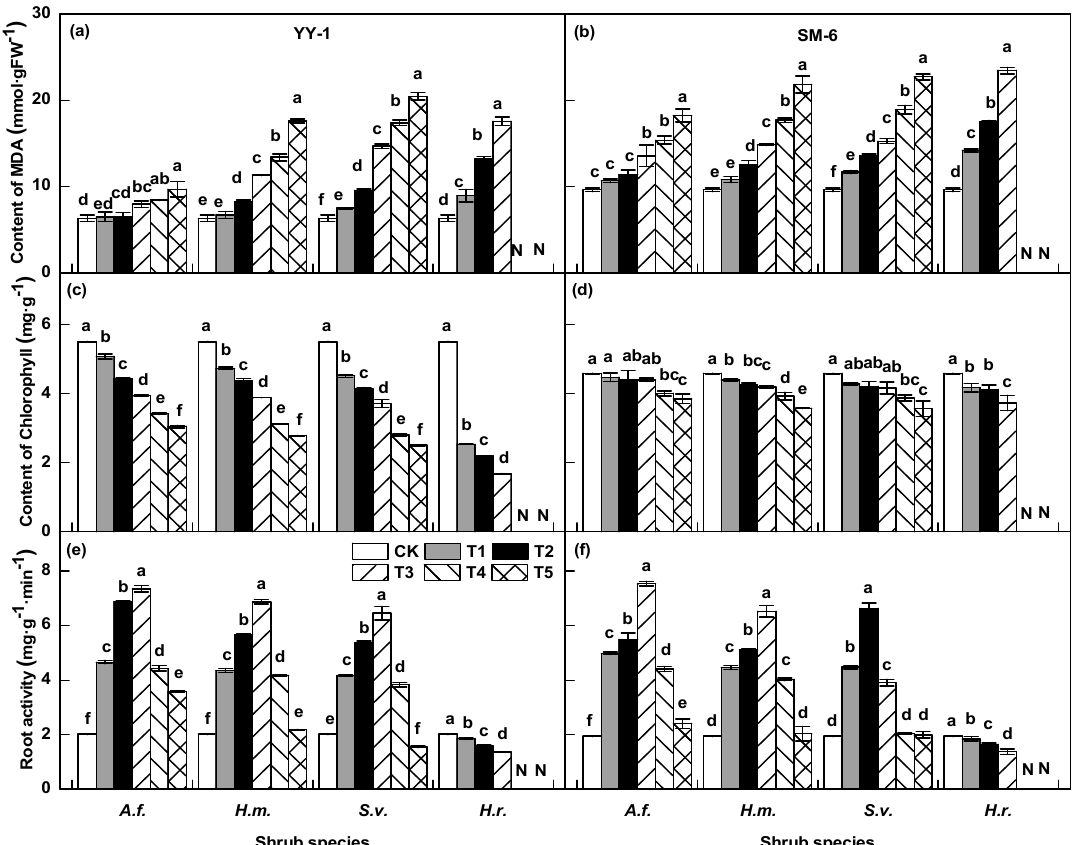
Figure 4. Effect of different concentrations of four shrub species’ aqueous leaf extracts on MDA, chlorophyll content, and root activity of A. pedunculata . ( a – f ). Data (Mean ± Standard Error, n = 42) of MDA content ( a , b ), chlorophyll content ( c , d ), and root activity ( e , f ) of the target A. pedunculata species of YY-1 and SM-6 seedlings exposed to six concentrations 0 (CK), 0.025 (T1), 0.05 (T2), 0.1 (T3), 0.15 (T4), and 0.2 g · mL − 1 (T5) of aqueous leaf extracts from the donor species— Amorpha fruticosa ( A.f. ), Hedysarum mongolicum ( H.m. ), Sabina vulgaris ( S.v. ), and Hippophae rhamnoides ( H.r. ). N means no value (all the plants death and no relevant indicators have been detected). Different little letters indicate significant difference ( p < 0.05). Vertical bars represent standard errors ( n = 4).